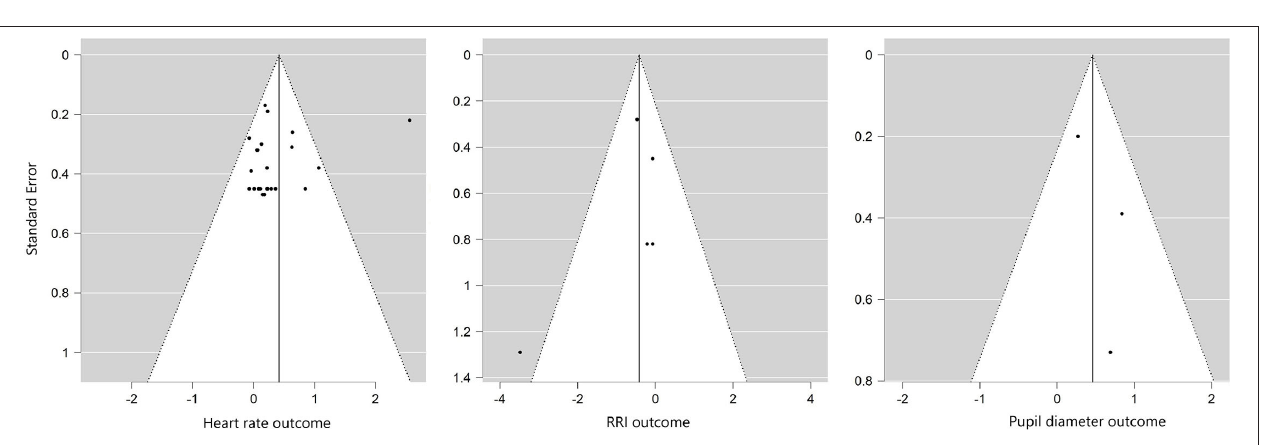
FIGURE 2 | Visualization of funnel